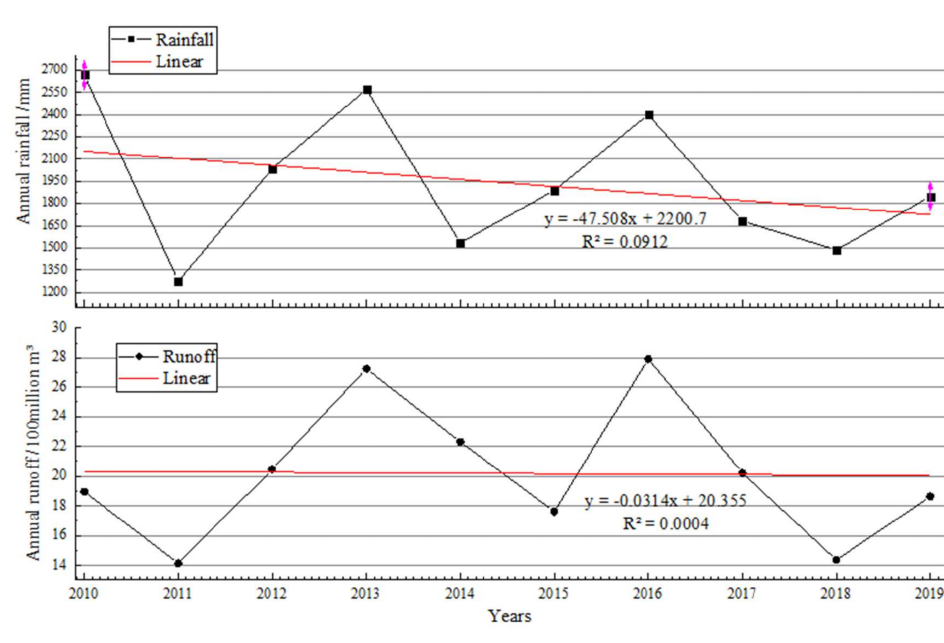
Figure 4. Trend analysis of rainfall and